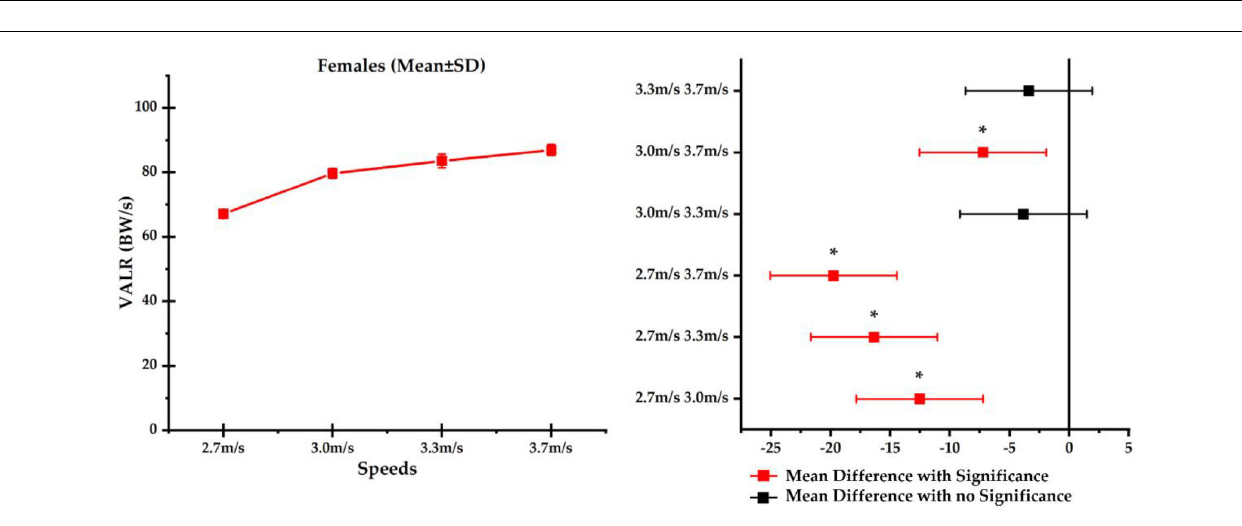
FIGURE 4 | Comparison of vertical average loading rates (VALRs) across different running speeds (mean ± SD), (left) and mean difference (right) in female runners with significance highlighted in red and asterisk